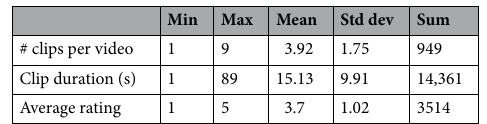
Table 1. Dataset statistics.